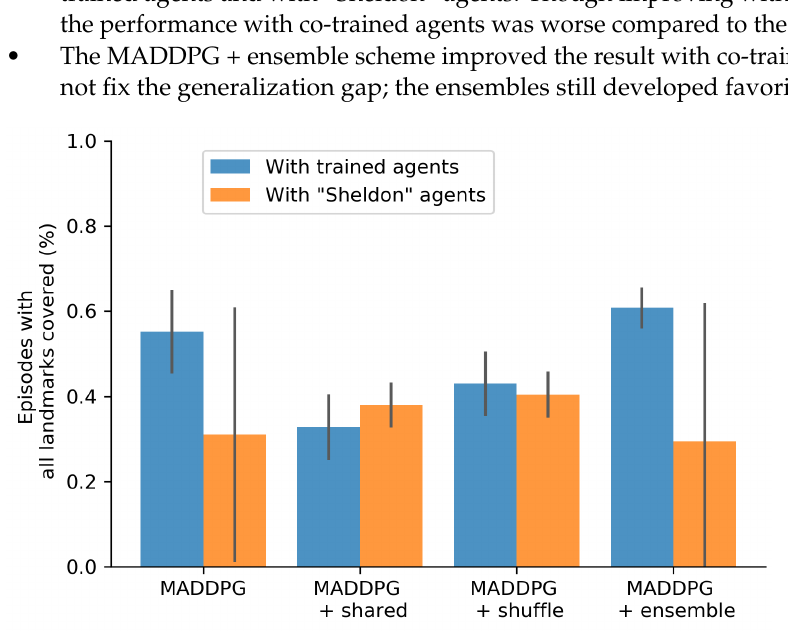
Figure 5. The percentage of episodes where all three landmarks were covered for each training scheme. The blue bars represent the means and standard deviations over 5 runs for all trained agents. The orange bars represent the means and standard deviations over 5 × 9 runs with two “Sheldon” agents and one trained agent. For numerical results and significance p -values, see Tables A1 and A2 in Appendix